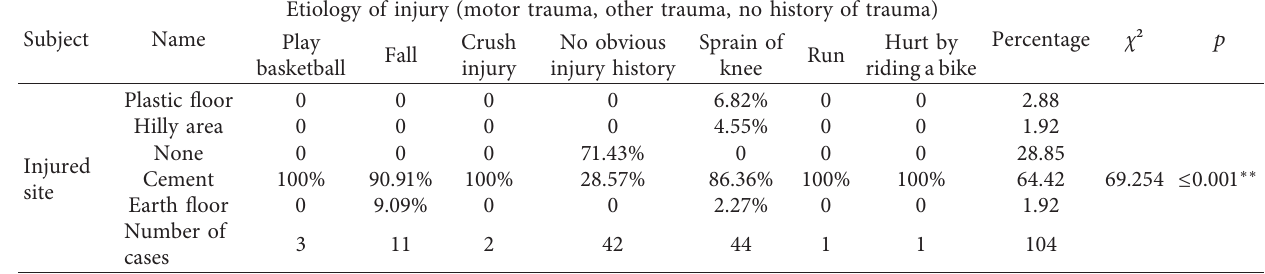
Table 5: Cross-over (chi-square) analysis.